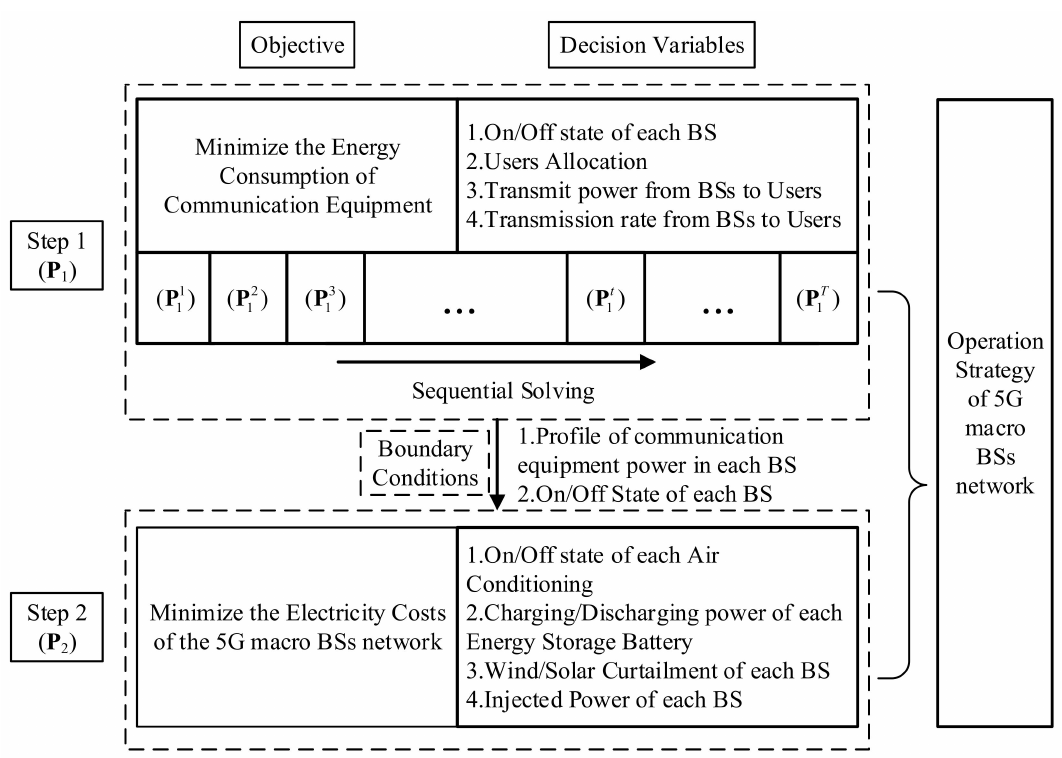
Figure 3. Framework of the energy management model of the 5G macro BS